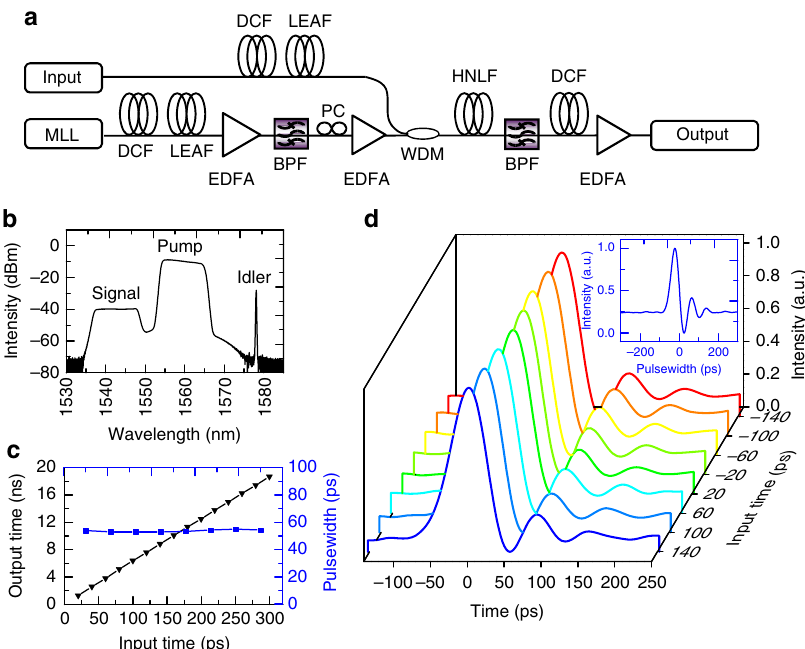
Fig. 2 Schematic representation and performance of the low-aberration time magni fi er. a Experimental setup of the low-aberration time magni fi er with the parametric time lens implemented through FWM in a 50 m HNLF. To minimize the third-order-dispersion-induced aberration, both the input and the pump dispersions are provided by proper combination of DCF and LEAF. b The optical spectrum after the HNLF when measuring a 470 fs pulse. The narrow-band idler is fi ltered out, dispersed and ampli fi ed to become the fi nal output of the time magni fi er. c The output time ( black , left axis ) and pulsewidth ( blue, right axis ) of the time magni fi er as a function of the input time, measuring a temporal magni fi cation ratio of 61.5 and a consistent temporal resolution of 740 fs across the 300 ps recording window. d The normalized output waveforms of the system when the input pulse is temporally shifted across the recording window. The corresponding output waveforms at each input time are labelled by a different colour. ( inset ) The impulse response of the photodetector. MLL mode-locked laser, EDFA erbium-doped fi bre ampli fi er, BPF band-pass fi lter, PC polarization controller, WDM wavelength-division